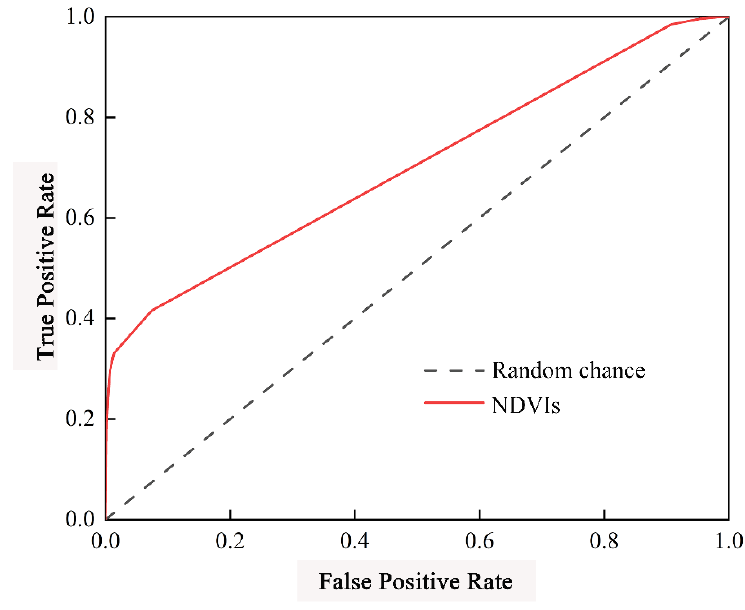
Figure 7. ROC curve of the slope of NDVI change.